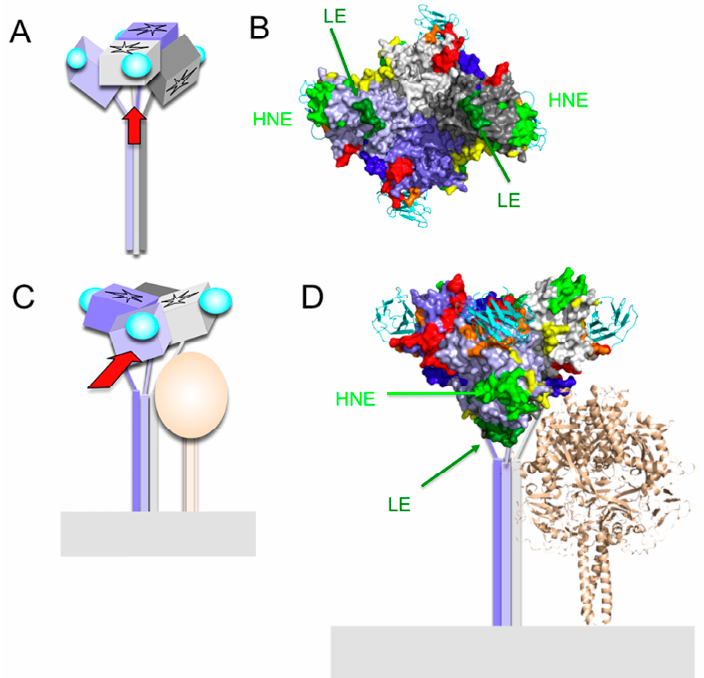
Figure 5. Predicted positional relationship between the MV-H tetramer (form I) and MV-F. ( A – D ) Four H protein molecules are shown in gray, light gray, purple, and light purple. SLAM is shown in cyan. ( C , D ) MV-F is shown in light brown. ( A , C ) Schematic diagrams of the MV-H tetramer (form I) and MV-F. Red arrows in A and C indicate the direction of sight in B and D, respectively. ( B , D ) Surface presentation models of MV-H. Ribbon diagrams show SLAM (cyan) and MV-F (light brown). The structural model of MV-F has been reported previously [59].